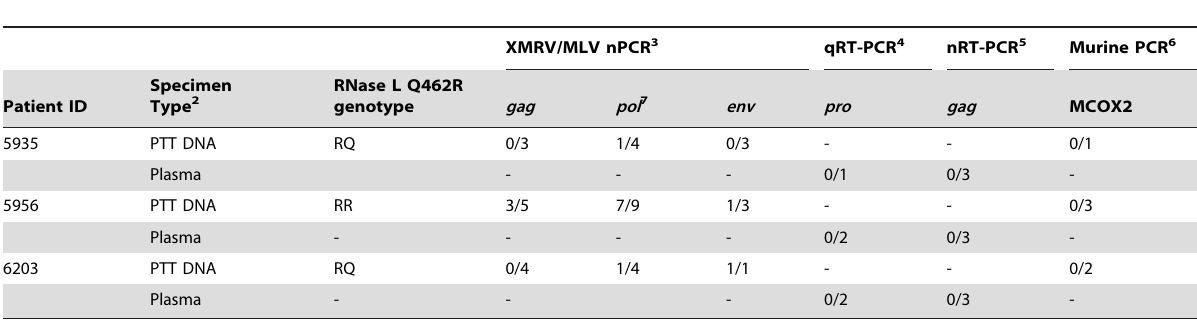
Table 2. Detection of XMRV in three prostate cancer patients 1